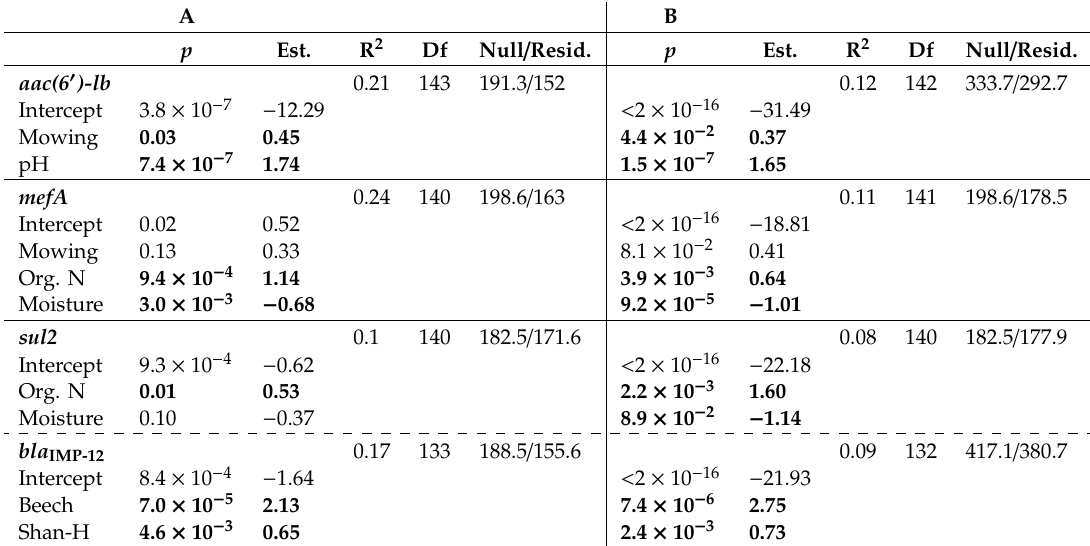
Table 1. Final regression models of the occurrence (binomial model: A) or relative abundance (tobit model: B) of antibiotic resistance genes. At least one of the two models was supposed to explain ≥ 10% of the variance (R 2 ) and p values < 0.05 were considered significant (highlighted in bold). The outer left column lists the dependent (shown in bold) and independent variables of each model (also intercept is considered with respect to each model). The models below the dashed bar focus on bla IMP-12 in forest soils and the other models focus on aac(6 (cid:48) )-lb , mefA and sul2 in grassland soils. Est. is the abbreviation for estimate, Moisture for soil moisture, Shan-H for fungal diversity as assessed by Shannon index, Df stands for degrees of freedom and Null / Resid. for the null or residual deviance,